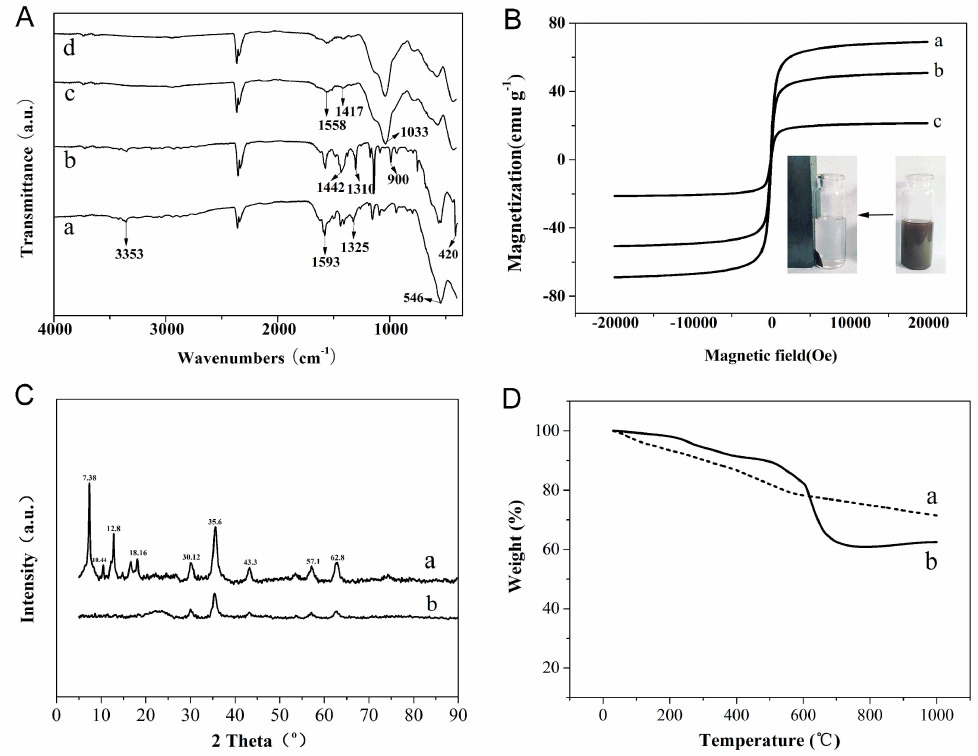
Figure 2. ( A ) FT − IR spectra of Fe 3 O 4 (a), Fe 3 O 4 @ZIF-8 (b), Fe 3 O 4 @ZIF-8@MIP (c), and Fe 3 O 4 @ZIF- 8@NIP (d); ( B ) magnetization curves of Fe 3 O 4 (a), Fe 3 O 4 @ZIF-8 (b), and Fe 3 O 4 @ZIF-8@MIP